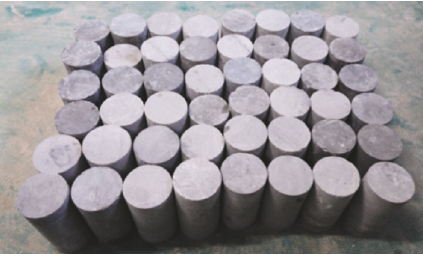
Figure 1: Standard cylindrical sandstone samples used in this